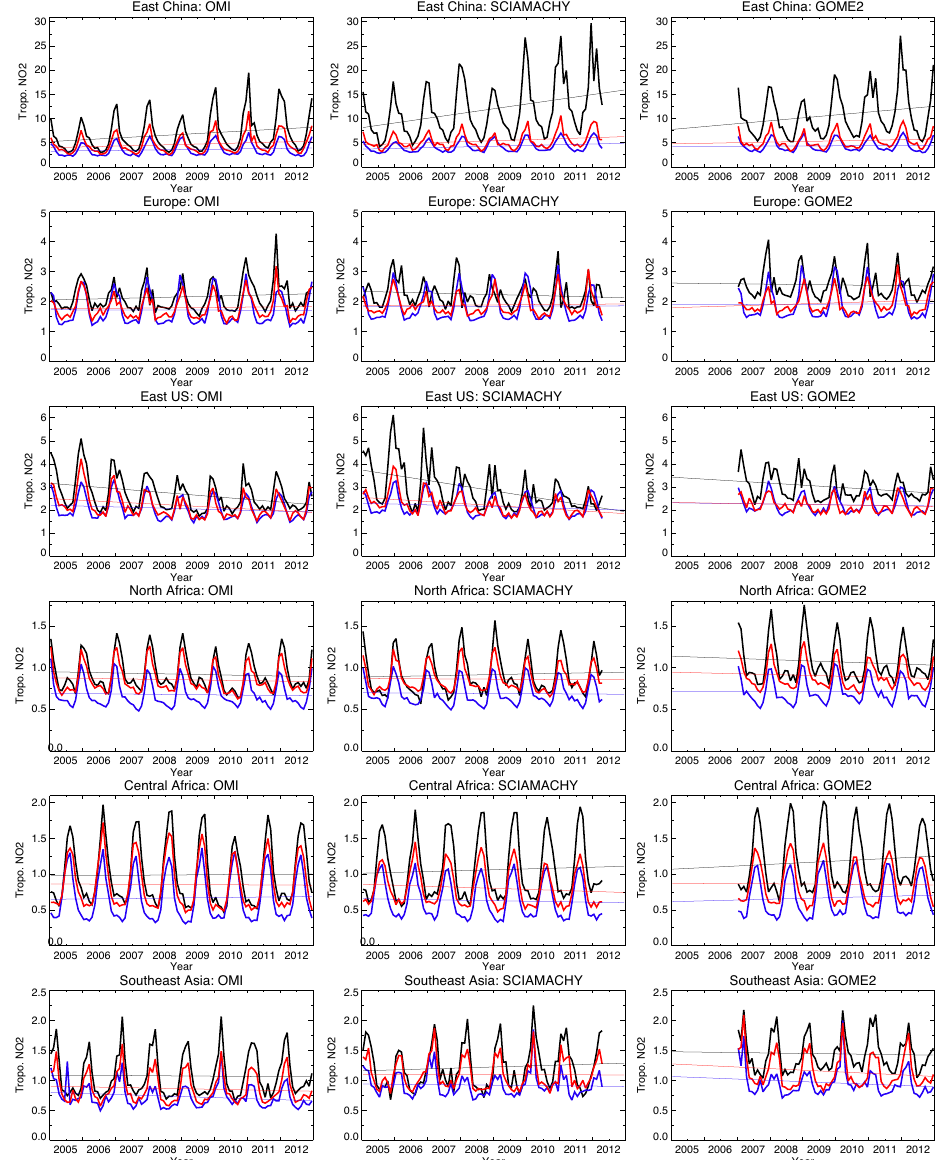
Figure 14. Time series of regional monthly mean tropospheric NO 2 columns (in 10 15 moleccm − 2 ) averaged over eastern China (110–123 ◦ E, 30–40 ◦ N), Europe (10 ◦ W–30 ◦ E, 35–60 ◦ N), the eastern United States (71–95 ◦ W, 32–43 ◦ N), North Africa (20 ◦ W–40 ◦ E, Equator–20 ◦ N), Central Africa (10–40 ◦ E, Equator–20 ◦ S), Southeast Asia (96–105 ◦ E, 10–20 ◦ N) obtained from the satellite retrievals (black), control run (blue), and reanalysis (red). Results are shown for the OMI retrievals (left columns), SCIAMACHY retrievals (centre columns), and GOME-2 retrievals (right